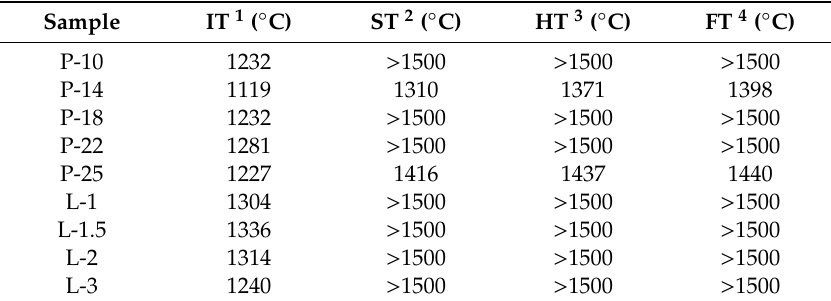
Table 4. Fusibility of pellet ash.